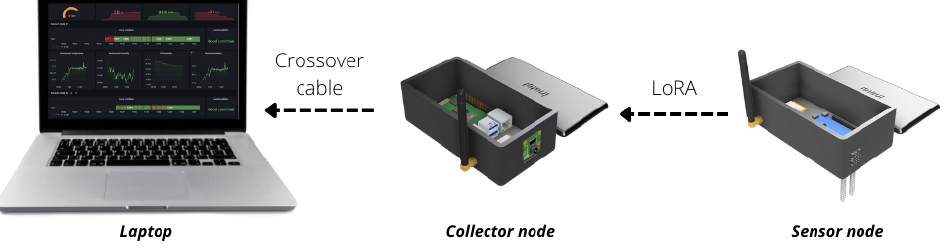
Figure 14. Platform connection schema used in strawberry